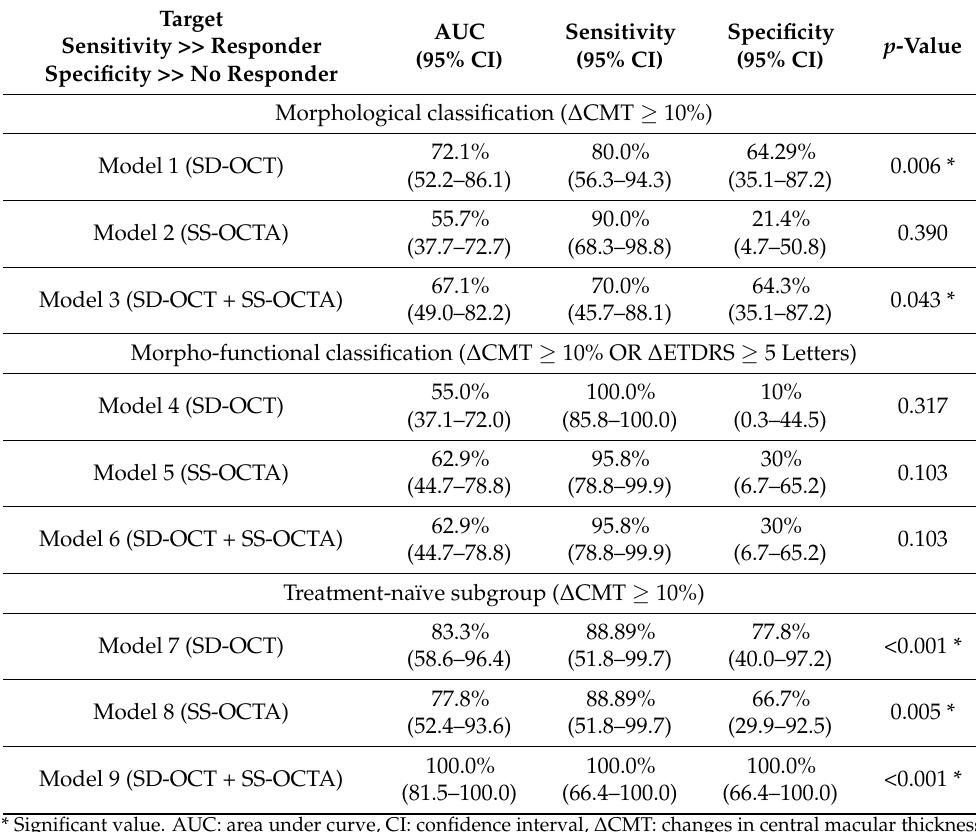
Table 3. Models’ performance